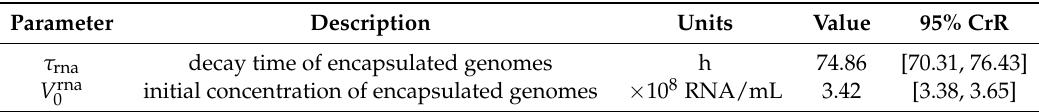
Table 2. Parameter values obtained from fitting Equation (1) to encapsulated genome data. 95% CrRs were constructed from Markov chain Monte Carlo (MCMC) fits of the model (1) to encapsulated genome